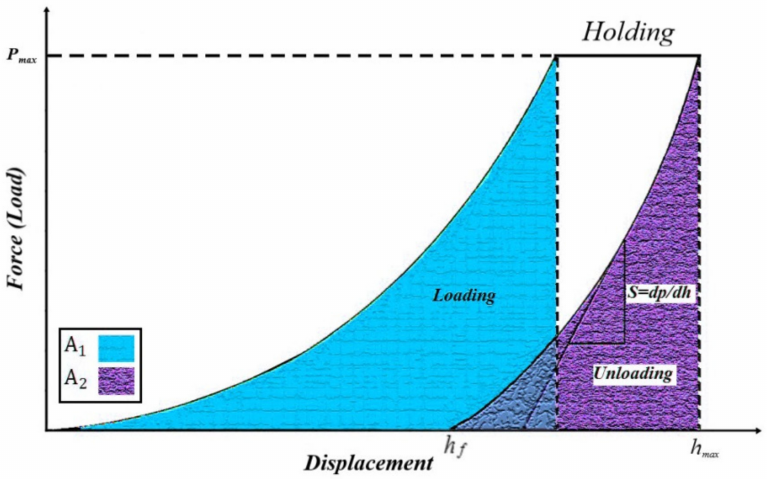
Figure 6. Force-displacement curve in a nano-indentation